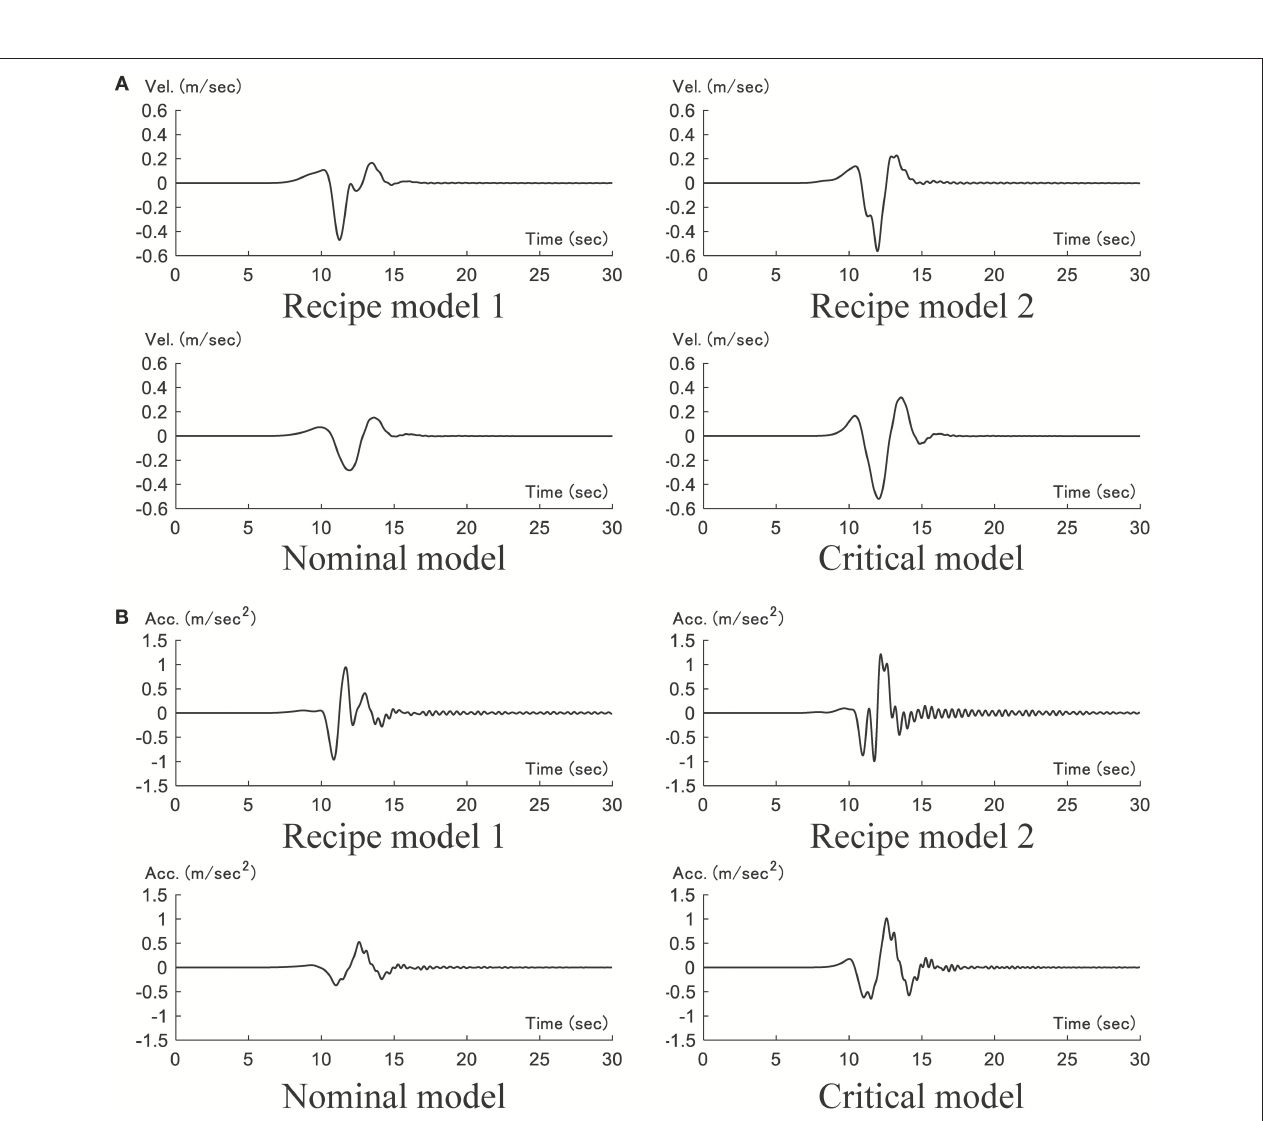
FIGURE 7 | Time history of ground motion (component of transverse) for each fault model. (A) velocity. (B) acceleration.